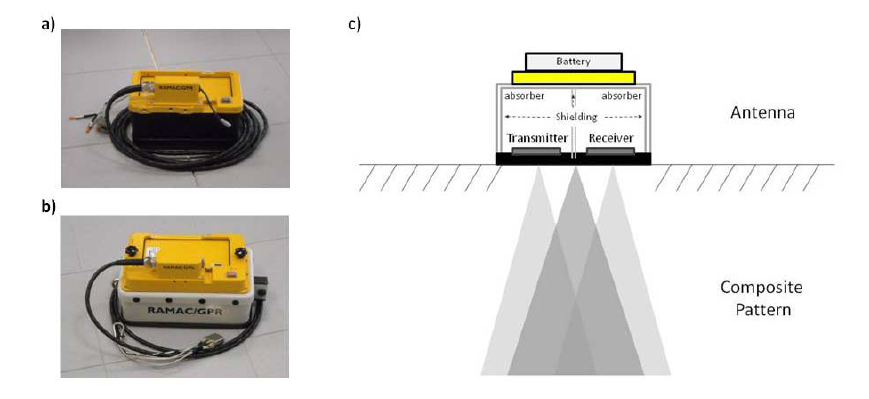
Figure 2 . Antennas under test. (a) 1 GHz antenna. (b) 800 MHz antenna. (c) Composite radiation pattern of a ground-coupled shielded antenna.